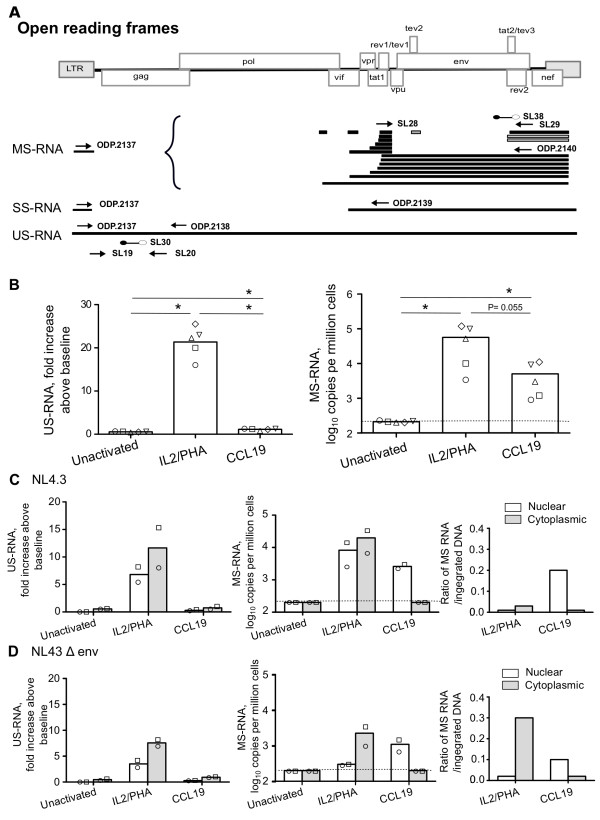
High level of nuclear MS RNA in CCL19-treated latently infected CD4+ T-cells. (A) Schematic diagram of the broad classes of HIV mRNA, including multiply spliced (MS) singly spliced (SS) and unspliced (US) HIV RNA (adapted from [56]). Location of primers and probes used for real-time PCR quantification of US, SS and MS RNA are shown. (B) Resting CD4+ T cells were activated with IL-2/PHA, CCL19 or unactivated and infected with NL4.3 or NL4.3Δenv. The fold increase in US RNA at day 4 post infection (relative to day 0; left panels) and the absolute copies per million cells of MS RNA (right panels) is shown for (B) total RNA following infection with WT NL4.3 (n = 5) and (C and D) nuclear (open) and cytoplasmic (grey) fractions following infection with (C) NL4.3 and (D) NL4.3Δenv. The mean (column) and individual data (open symbols) are shown. The ratio of MS RNA to integrated DNA for each donor is also shown (C and D, far right panel). The detection limit for US RNA and MS RNA was 200 copies/106 cells and is shown as dashed line for MS RNA. * = P < 0.05.